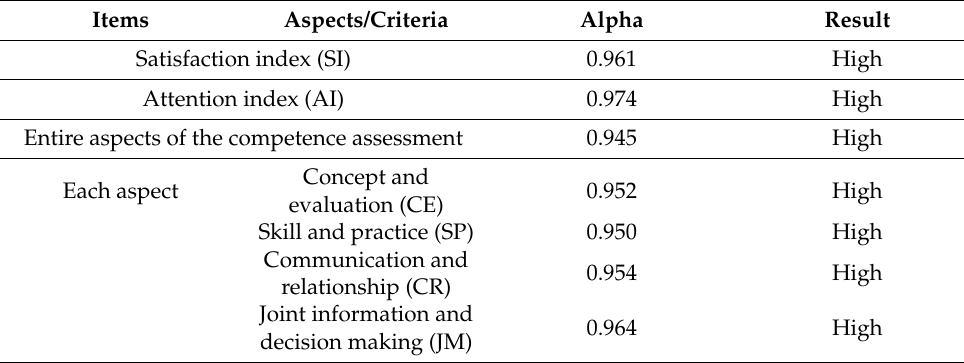
Table 3. The analysis of reliability (Cronbach α